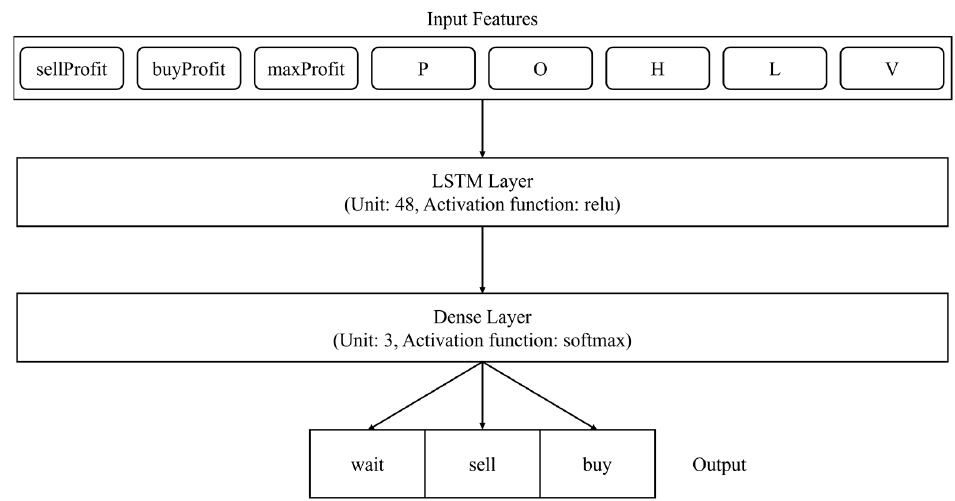
Figure 7. Deep learning model used in the experiment. Table 3. Value of hyperparameters used in the deep learning model.